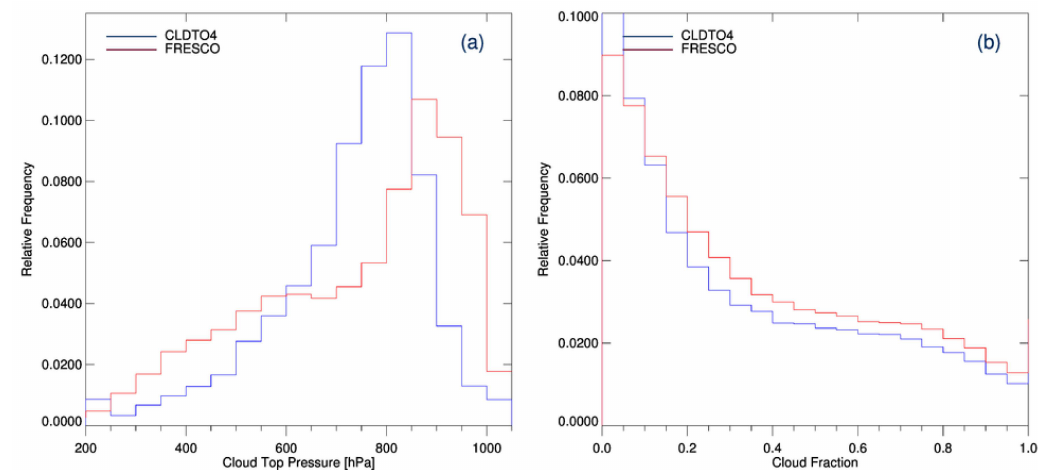
Figure 4. Probability distribution of ( a ) CTP and ( b ) CF by CLDTO4 and FRESCO.